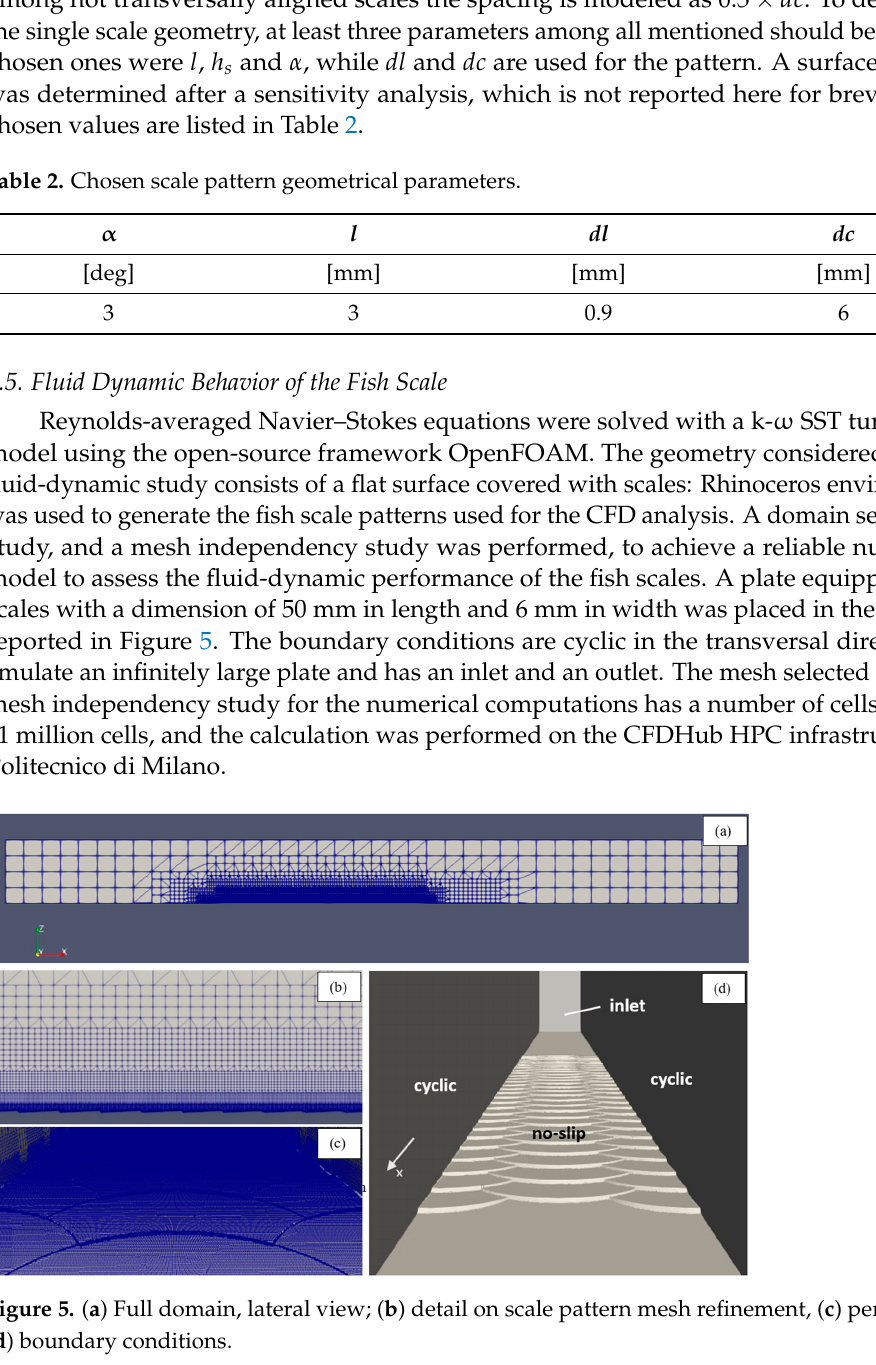
Table 3. Overall volume LPBF process parameters involved. Process Parameters